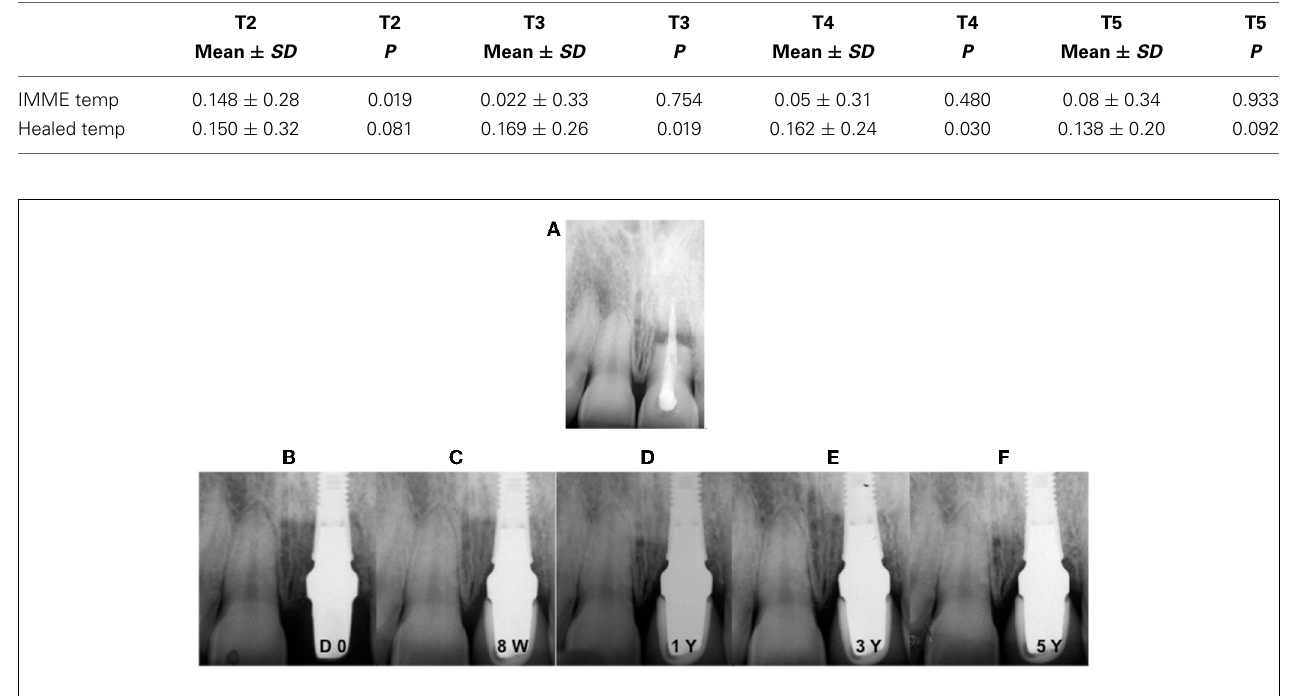
FIGURE 2 | Digital intra-oral radiographs of implants placed in fresh extraction socket with immediate loading at different observation times. (A) Pre-operative situation; (B) placement of